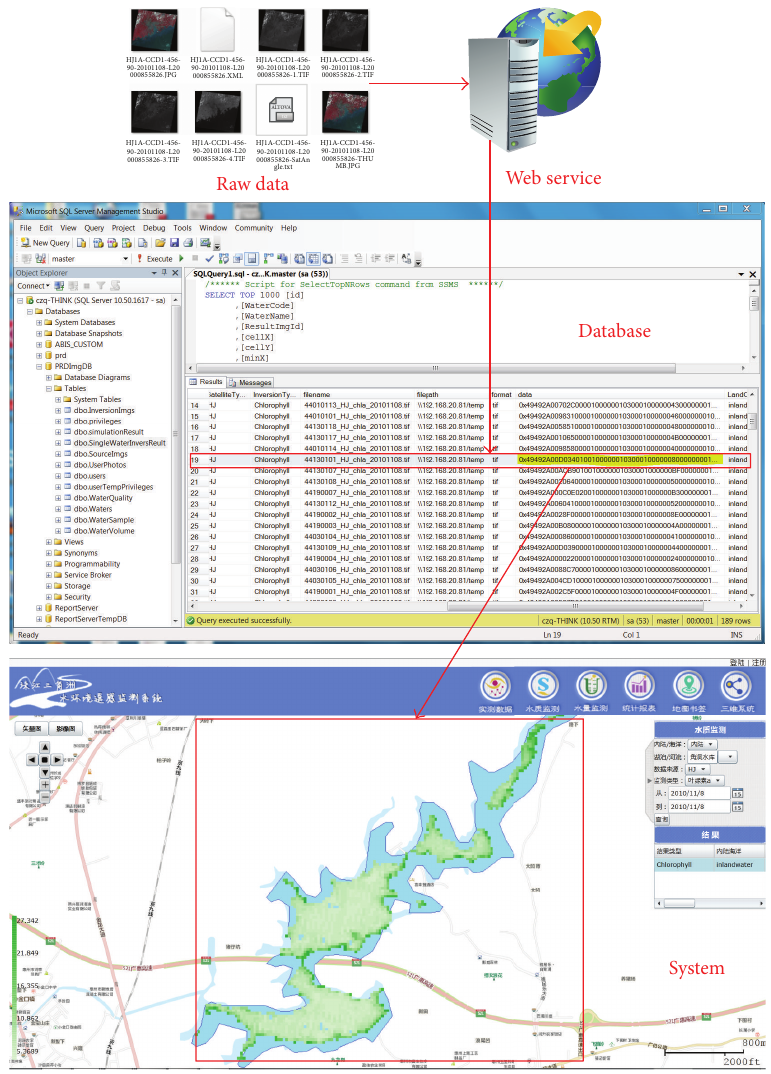
Figure 9: The result of scheme